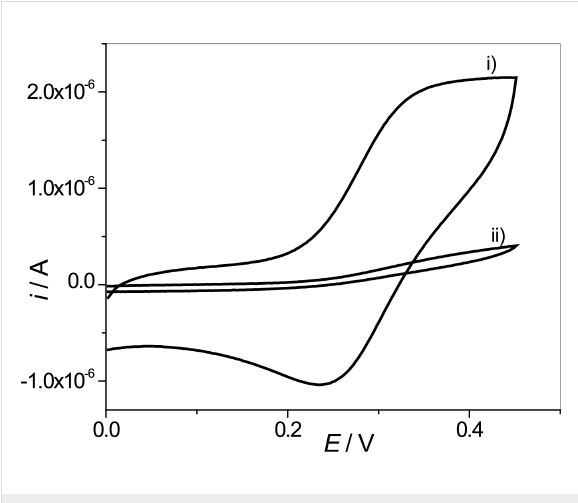
Figure 6: Cyclic voltammograms of K 4 [Fe(CN) 6 ] generated in phos- phate buffer solution (pH 7.0) by using AuE previously modified with AuNPs–SH–DOPC LUVs using SH/DOPC molar ratios of i) 0.33:1 and ii) 0.66:1 ( = 1 × 10 − 3 M, v = 100 mV·s − 1